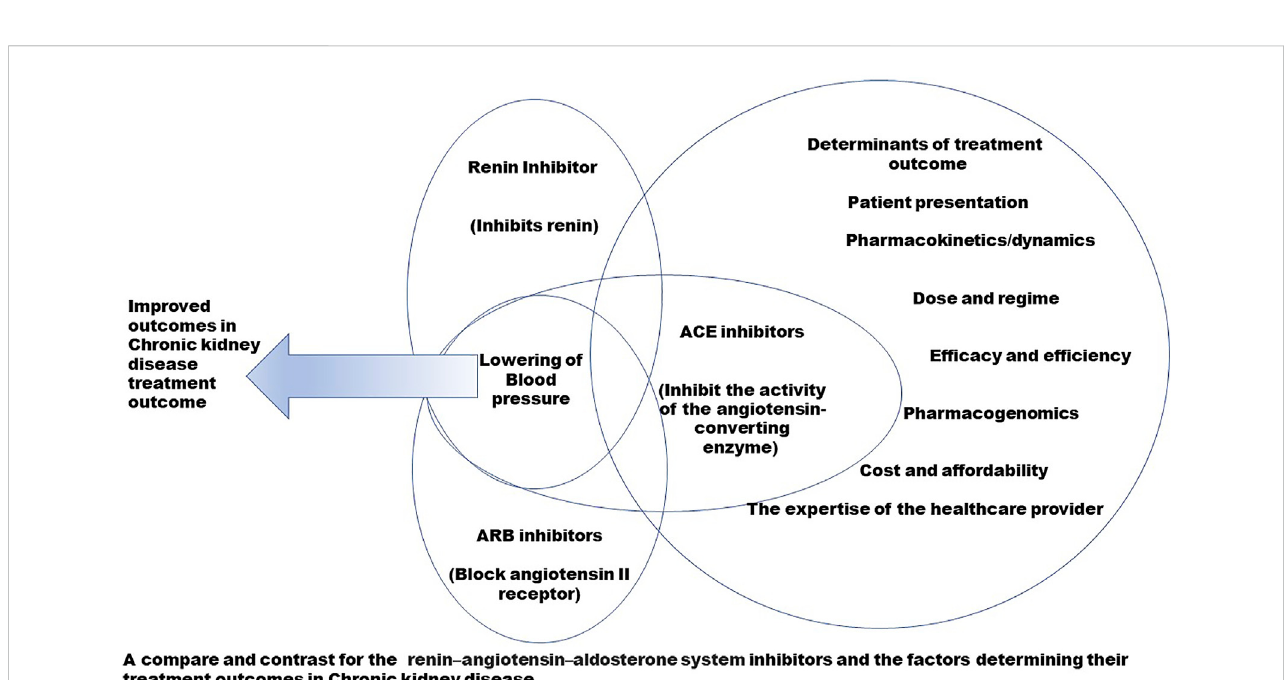
FIGURE 2 Graphical summary of the